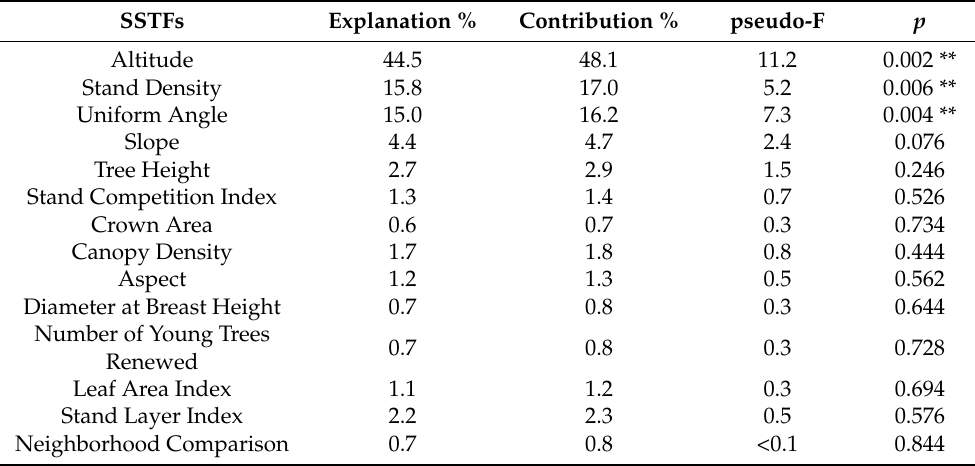
Table 3. The SSTFs-explained variance of the EFFIs of the Pinus tabuliformis forest.